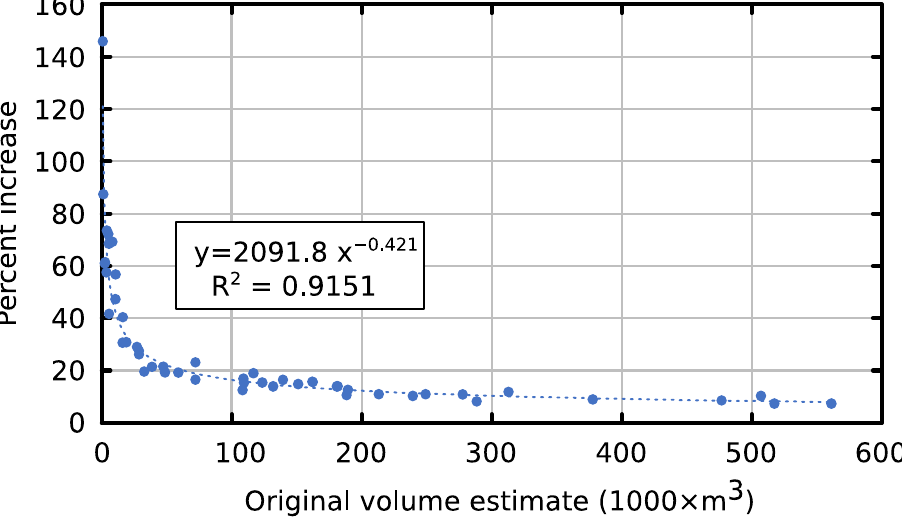
Figure 12. Relationship between percent increase in dilated volumes relative to original